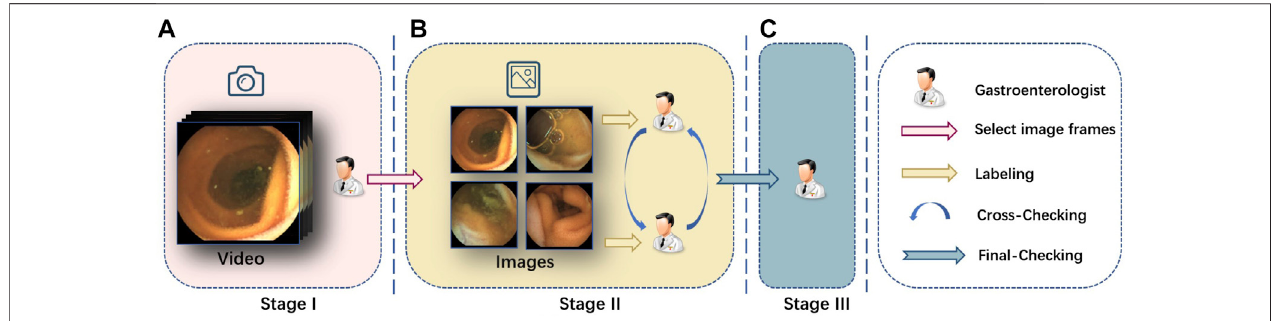
FIGURE 4 | Labeling pipeline we adopted. (A) In stage I, we invite several senior gastroenterologists to pick up the video clips of interest, and then we transform them into frames. (B) In stage II, we further invite another two gastroenterologists to label the clearness degree of the frames and semantic masks for each part. Cross validation is performed at the same time. (C) In stage III, a senior expert checks the labeling and makes the fi nal decision on the annotations.